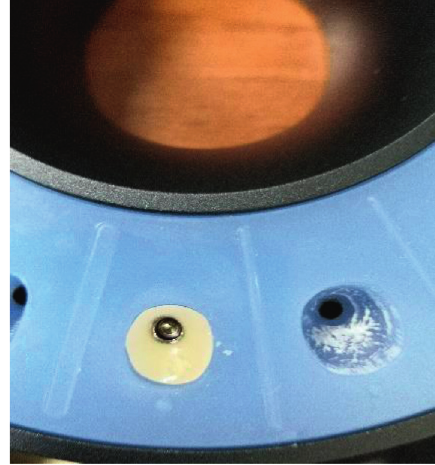
Figure 5: Stage of introducing the composite and polymerization.